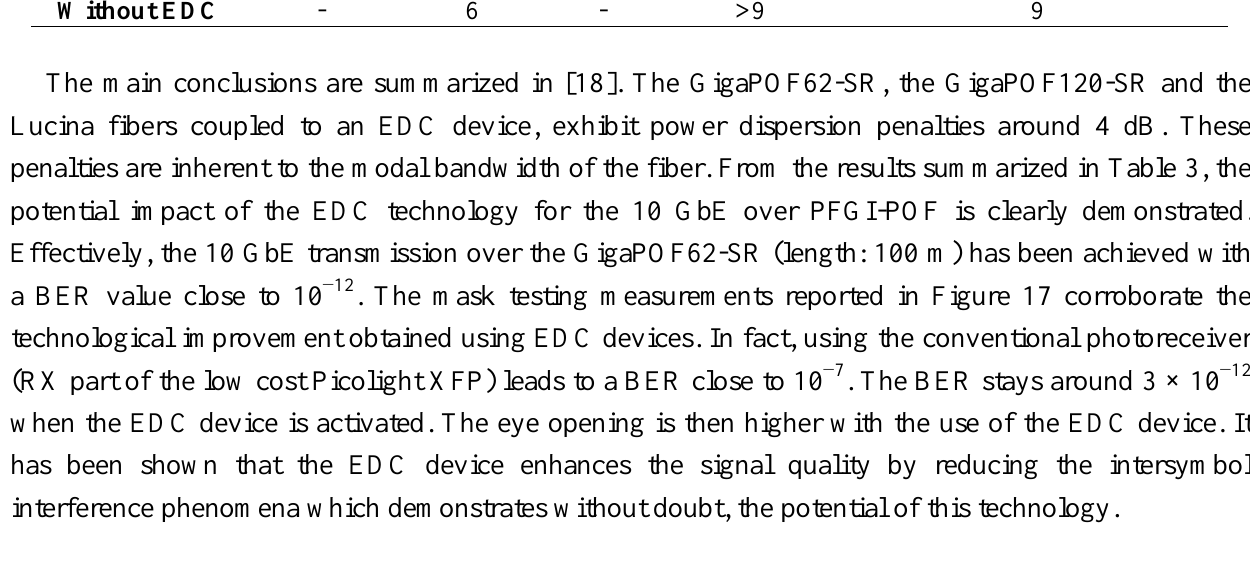
Figure 17. 10GBase-SR mask testing and isoBER measurement applied to GigaPOF62-SR.